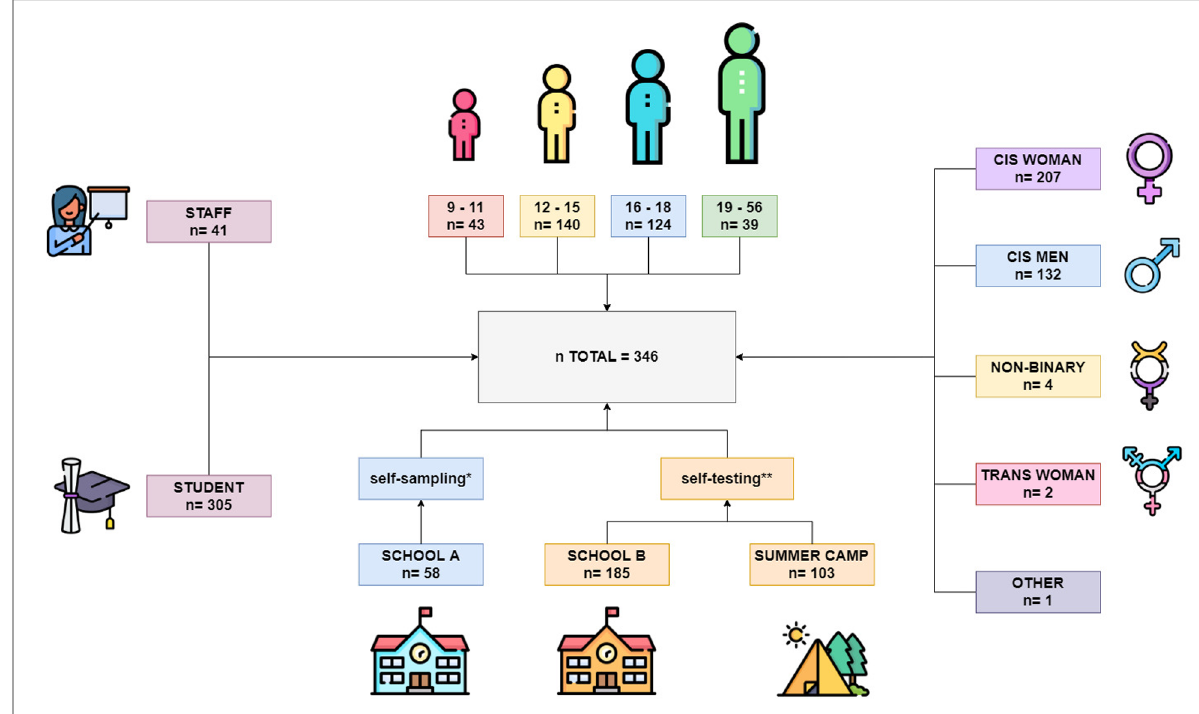
FIGURE 1 Summary of the total number of participants in the pilot study, Spain, N: 346. *Self-sampling: In school A, older pupils (15 – 16 years old) were trained beforehand to read the results of the other participants. ** Self-testing: In School B and summer camps, participants read the test result themselves, and the healthcare team validated the